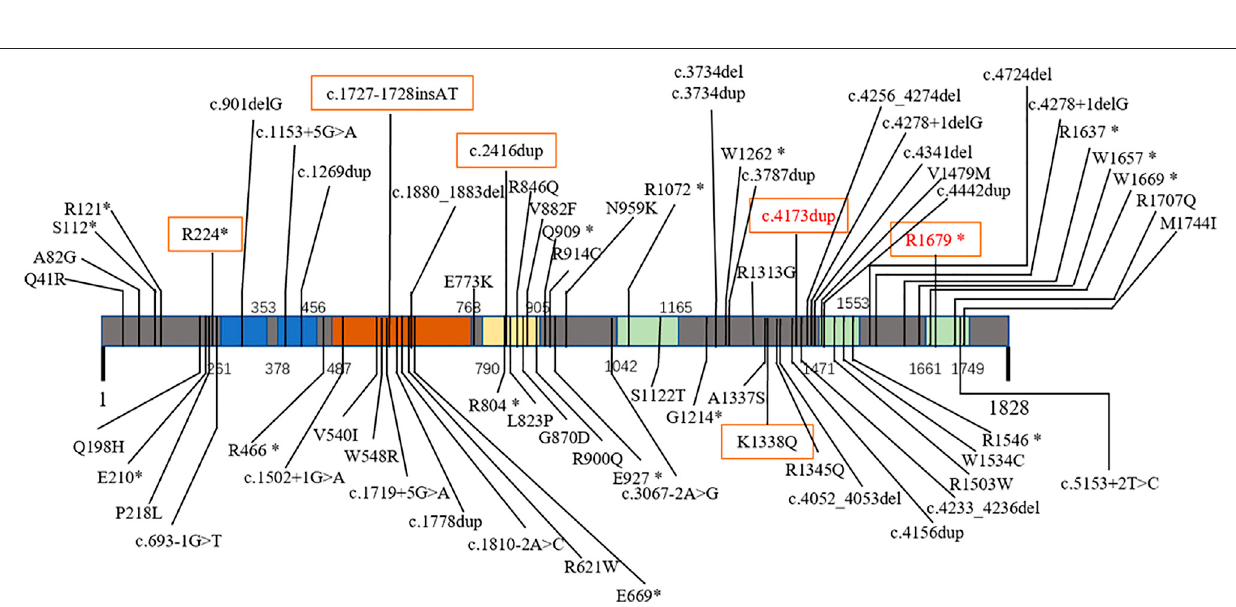
experiments. Each experiment was performed in duplicate. Data were analyzed using the Student ’ s t-test, and p < 0.05 was considered to be statistically signi fi cant.